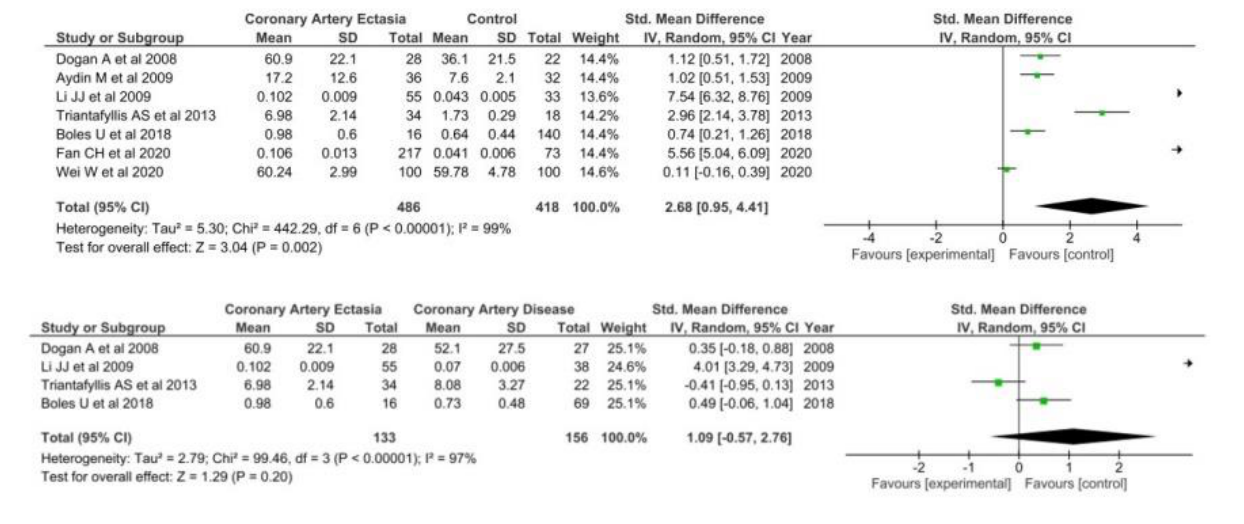
Figure 4. IL-6 in CAE patients versus control (top) and CAE versus CAD patients (bottom).